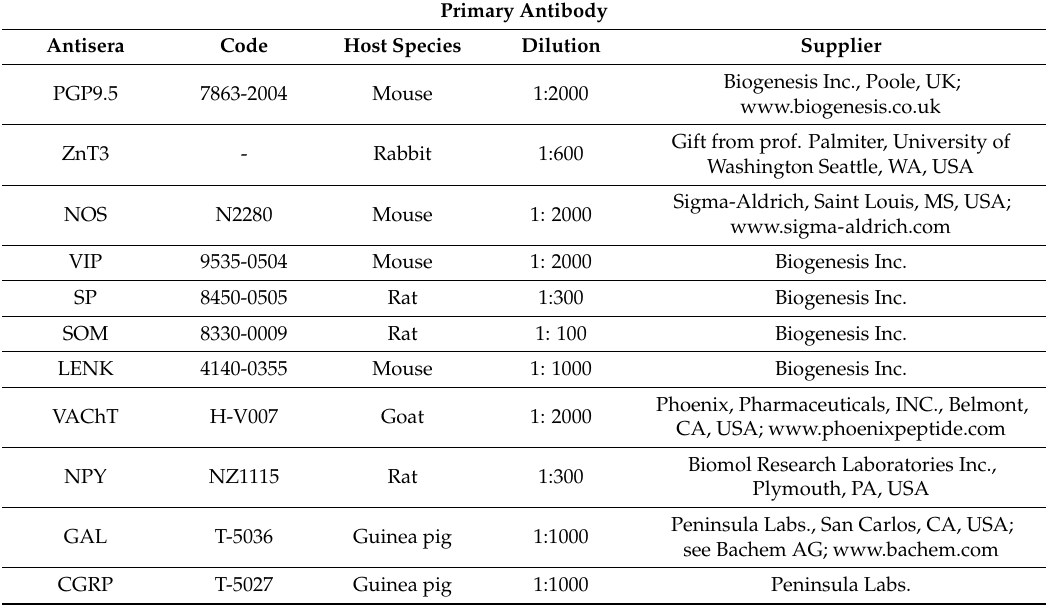
Specification of immune reagents used in the study: PGP9.5—protein